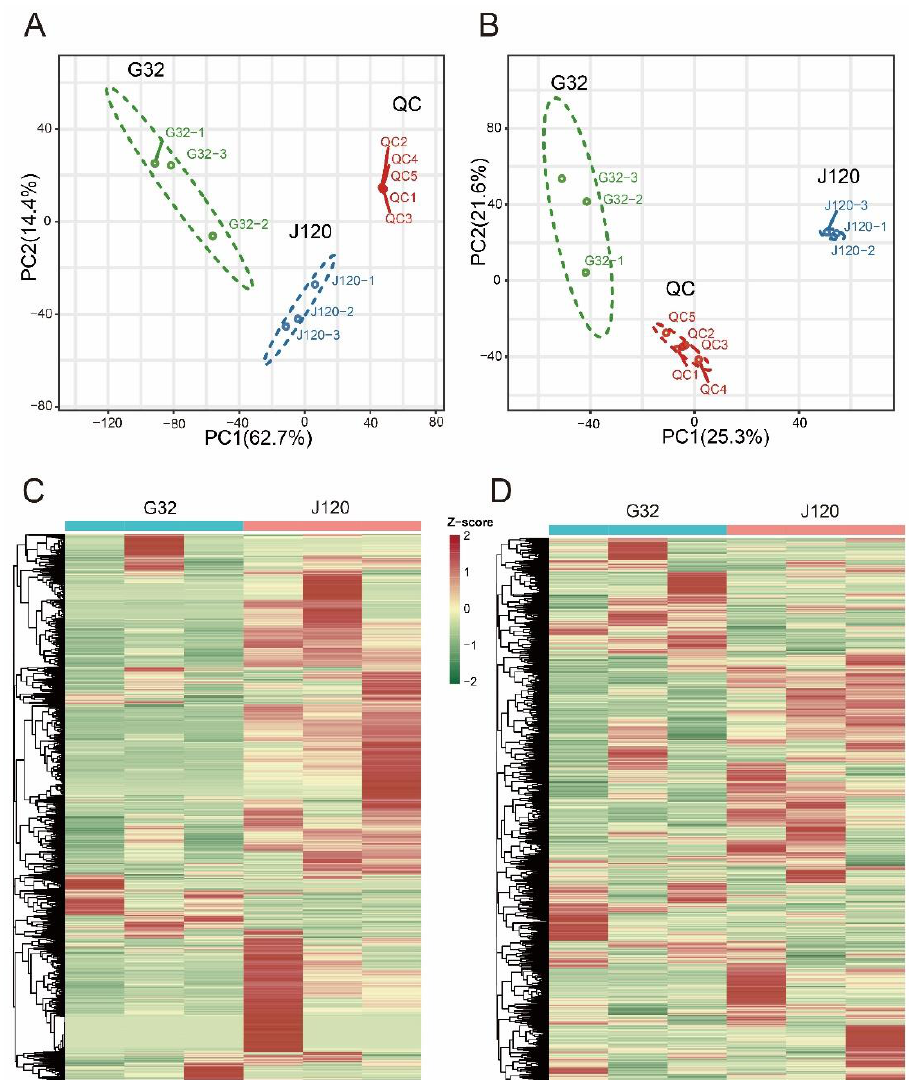
Figure 2. Differential fruit chemotype between “G32” and “J120”. ( A , B ): principal components analysis of identified metabolites from “G32” and “J120” in negative ionization (NEG) and positive ionization (POS) modes, respectively. A mixture of equal volumes of “G32” and “J120” samples was used for quality control (QC); ( C , D ): cluster analysis of metabolites from “G32” and “J120” fruit in NEG and POS modes, respectively. Colors indicate the level of accumulation of metabolites from low (green) to high (red).